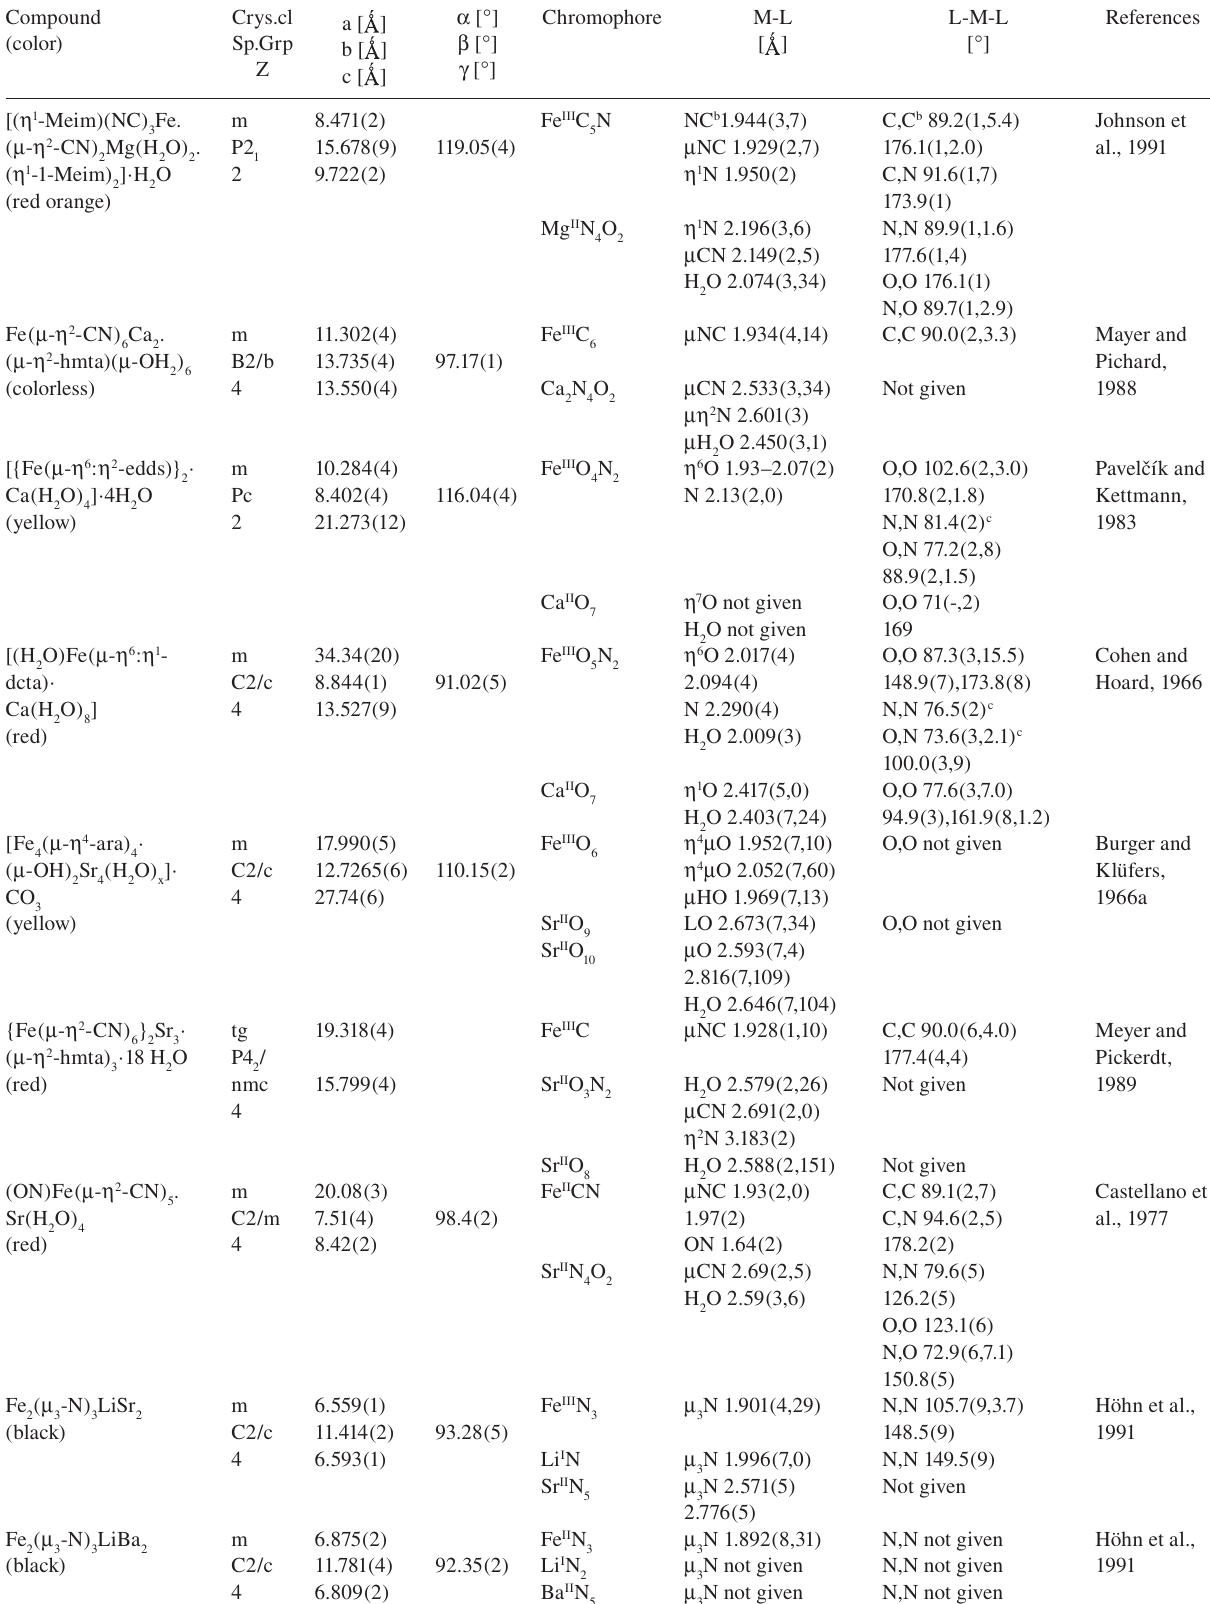
Table 1 Crystallographic and structural data for polymeric FeM (M = non-transition metals) a .